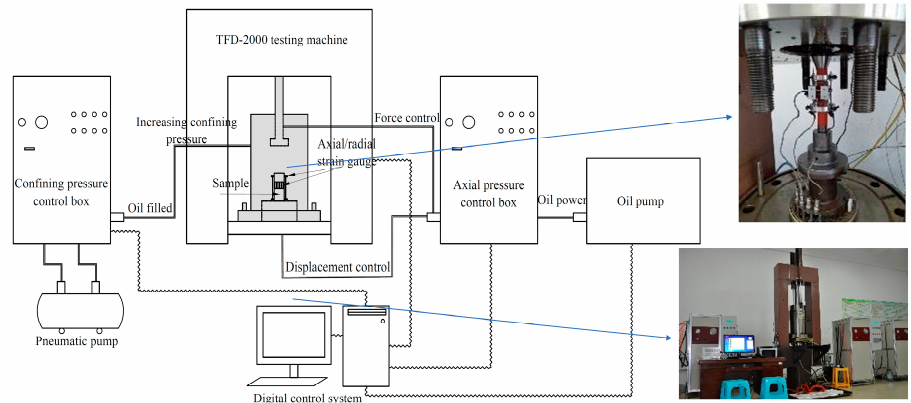
Figure 3. TFD-2000 microcomputer servo-controlled triaxial rheological testing machine. The testing equipment comprises axial loading, confining pressure loading, hydraulic pressure loading, numerical control and a measuring system. The maximum axial